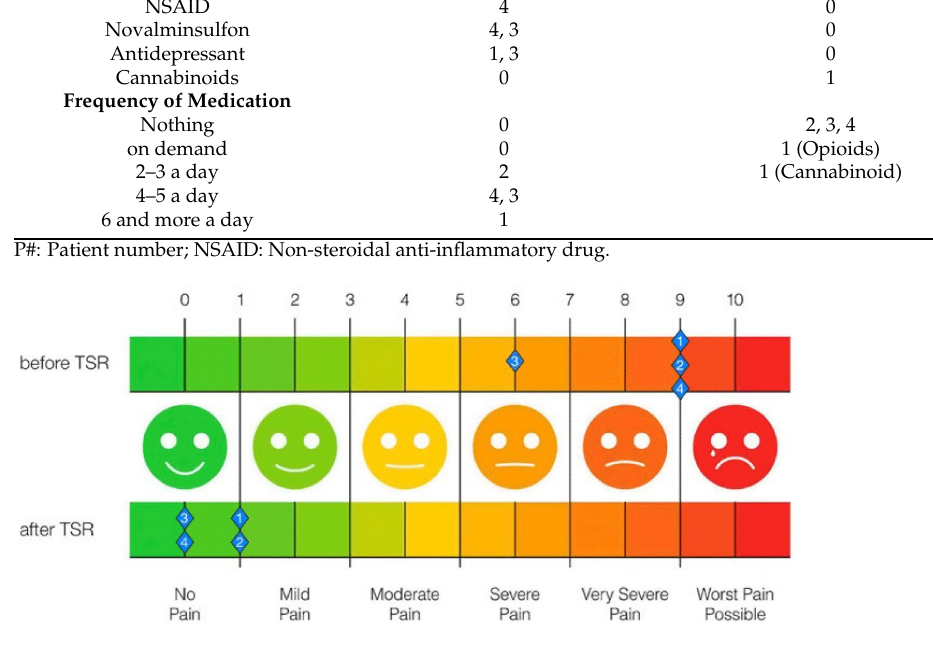
Figure 5. NRS scores before and after TSR surgery show a significant reduction in pain. Postoperative SF36 scores showed no significant difference compared with the general German population, except for general health. Compared with a lower extremity amputa- tion and a chronic neuropathic pain population, TSR patients reported significant better scores in 4 respectively 6 subscales (Figure 6).